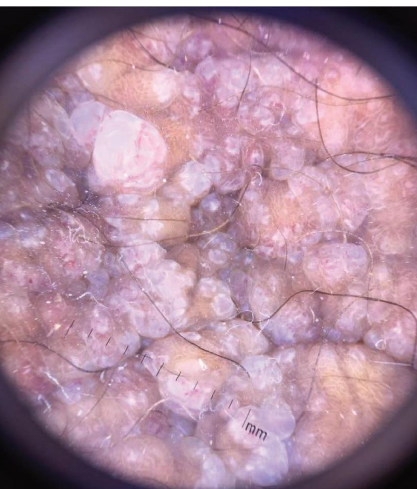
Figure 2: Dermoscopy shows multiple, densely distributed, round to oval, yellowish-white, reddish to purplish translucent lacunae surrounded by pale septa along with a few linear and punctate vessels and reddish to brownish scattered dots and